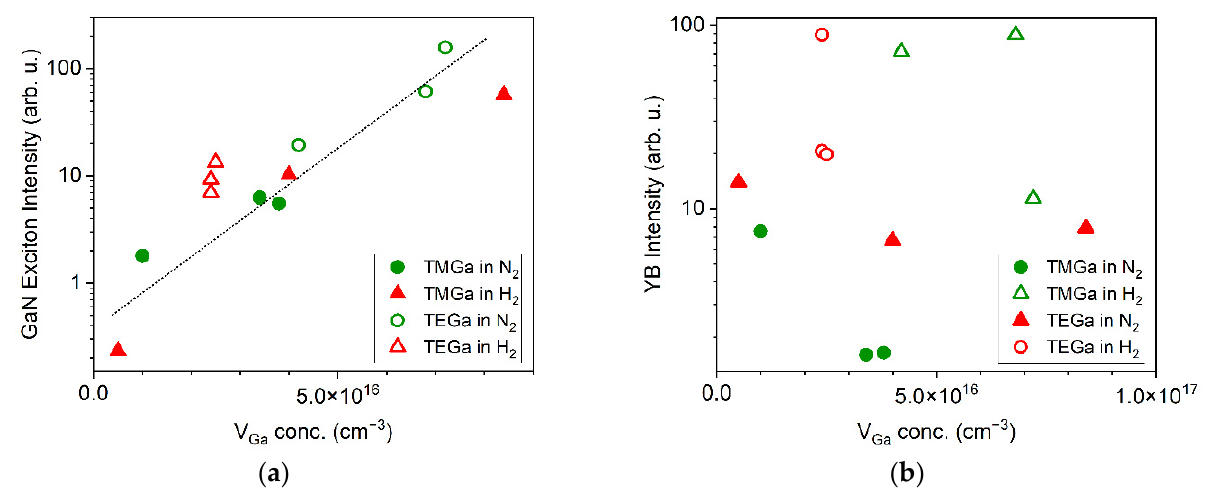
Figure 9. Maximum intensity of ( a ) excitonic and ( b ) yellow band luminescence as a function of V Ga concentration.